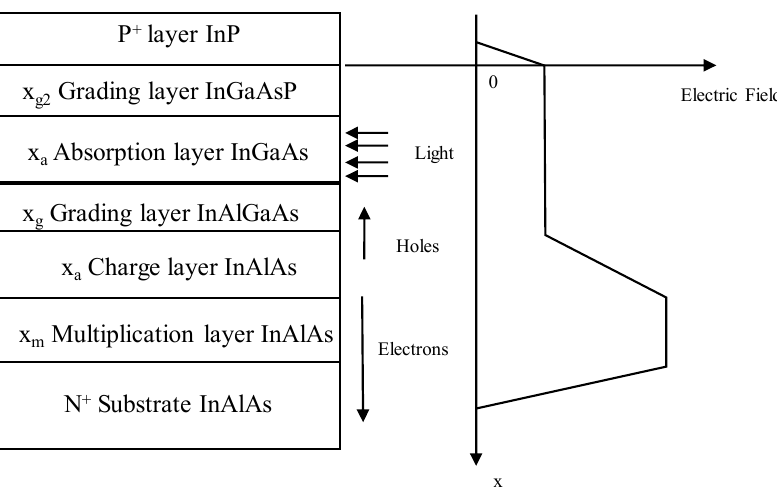
Figure 7. Schematic diagram of separate absorption, grading, charge, and multiplication (SAGCM) InGaAs/InAlAs APDs and its electric field distribution